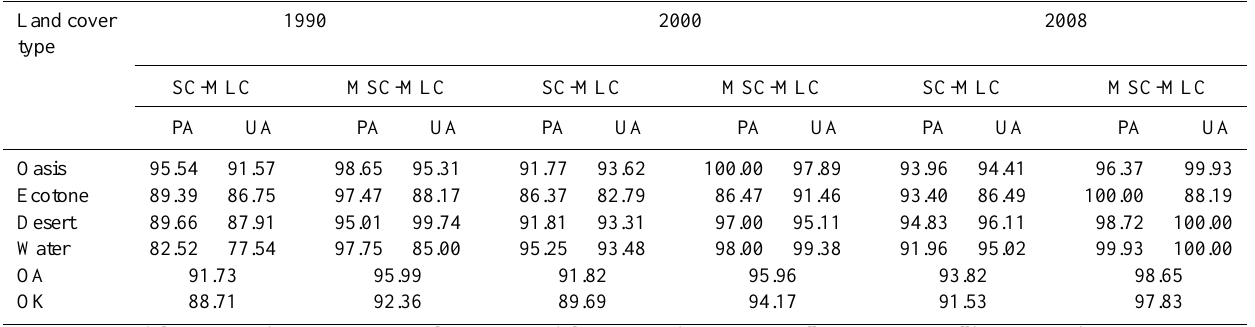
Table 2. Accuracies of land cover classifications derived from different classification methods (%). Land cover